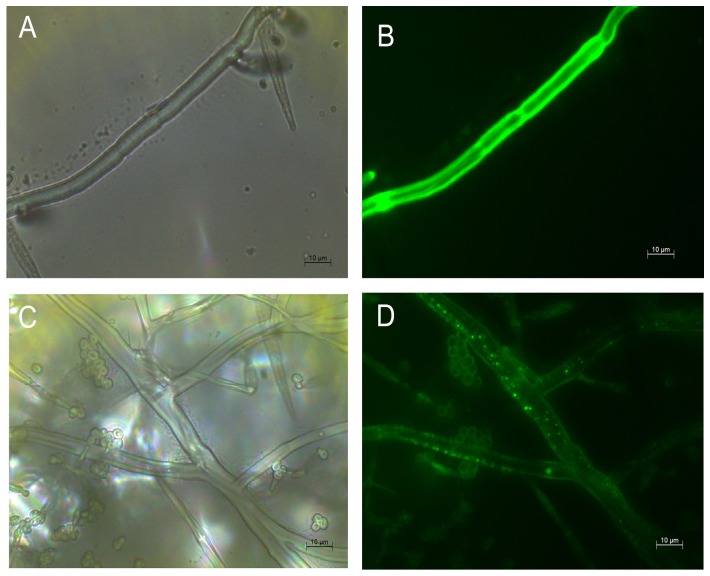
Subcellular localization of PAF-AH.(A) Micrographs of the positive control. (B) Fluorescent images of the positive control. (C) Micrographs of the PAF-AH protein-fused eGFP. (D) Fluorescent images of PAF-AH-fused eGFP. The eGFP was fused with the C terminus of the protein. Scale bars represent 10 µm.